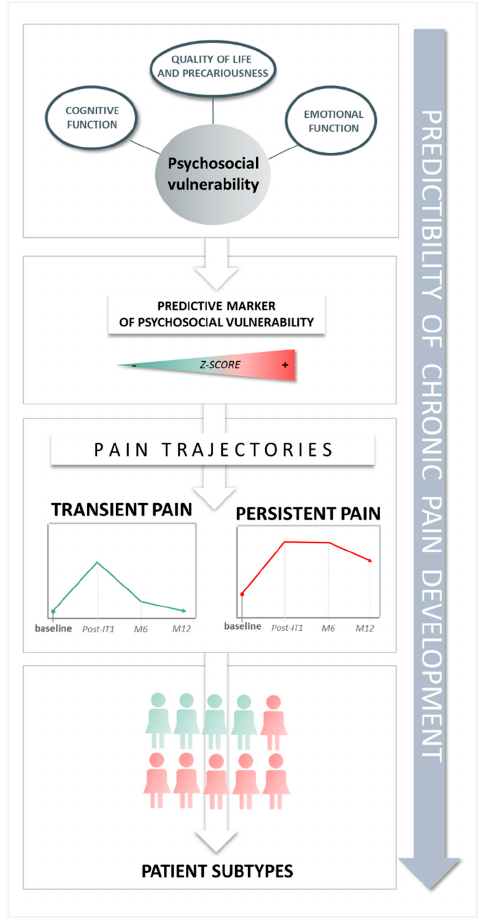
Figure 4. Key findings of the study.